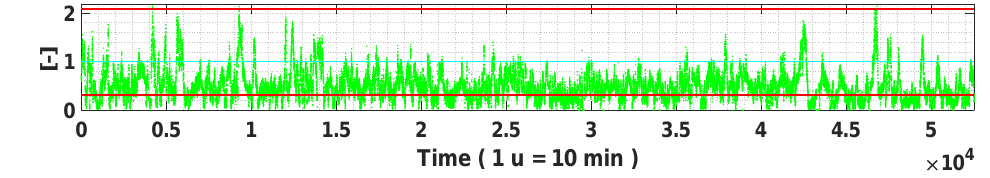
Figure 7. Wind Speed annual profile of the validation period and bounds of theoretical generated power.